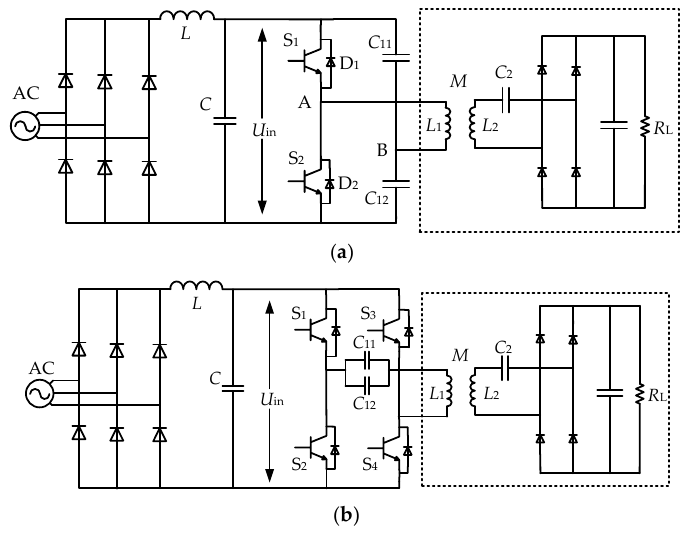
Figure 1. Comparison of the two topologies: ( a ) Proposed series-series / series (SS / S) symmetrical half-bridge resonant converter (SHRC)-based inductive power transfer (IPT) system; ( b ) The S / S full-bridge resonant converter (FRC) based system.